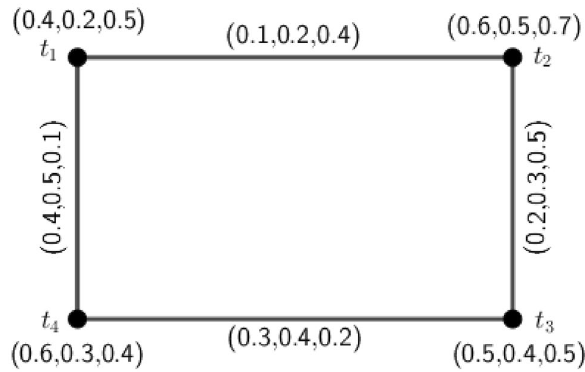
Figure 8. A 3PFG Γ 5 is nilpotent in the sence of